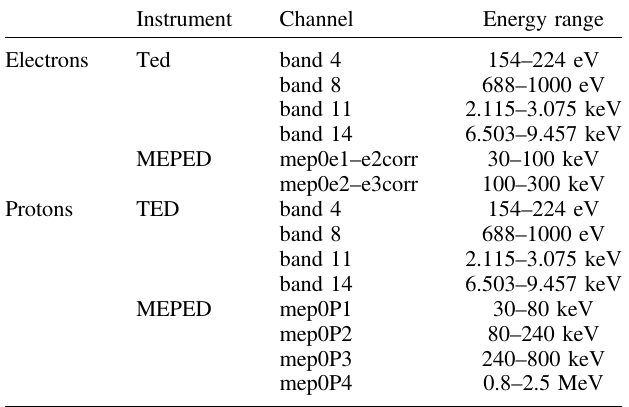
Figure 1. Original particle fl ux as given by the satellites is plotted against the recalculated fl ux. The cumulated distribution function (CDF, see x -axis) represents the probability that a speci fi c particle fl ux (or less) appears. Table 1. Channels and nominal energy range from the POES and Metop satellites which have been used. The construction of mep0e1 – e2corr and mep0e2 – e3corr is explained in Section